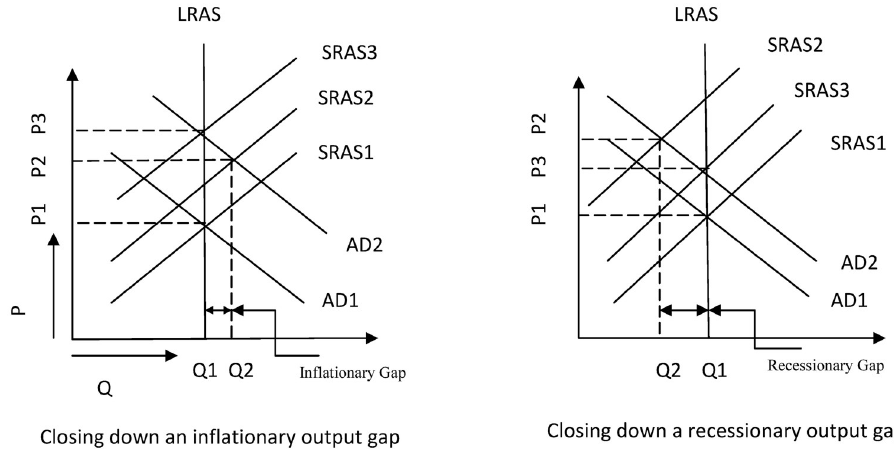
Fig 4. Mechanism of long run self